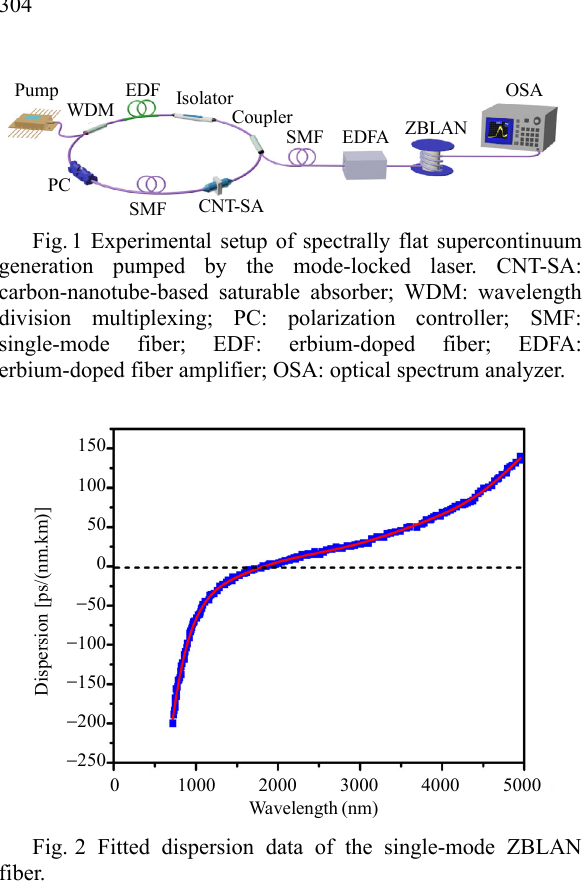
Fig. 3 Time and frequency domain characteristics of the seed laser: (a) mode-locked optical spectrum (blue curve) and autocorrelation trace of pulse and sech 2 -shape pulse fitting (red curve) and (b) corresponding RF spectrum, the insert picture is the output pulse